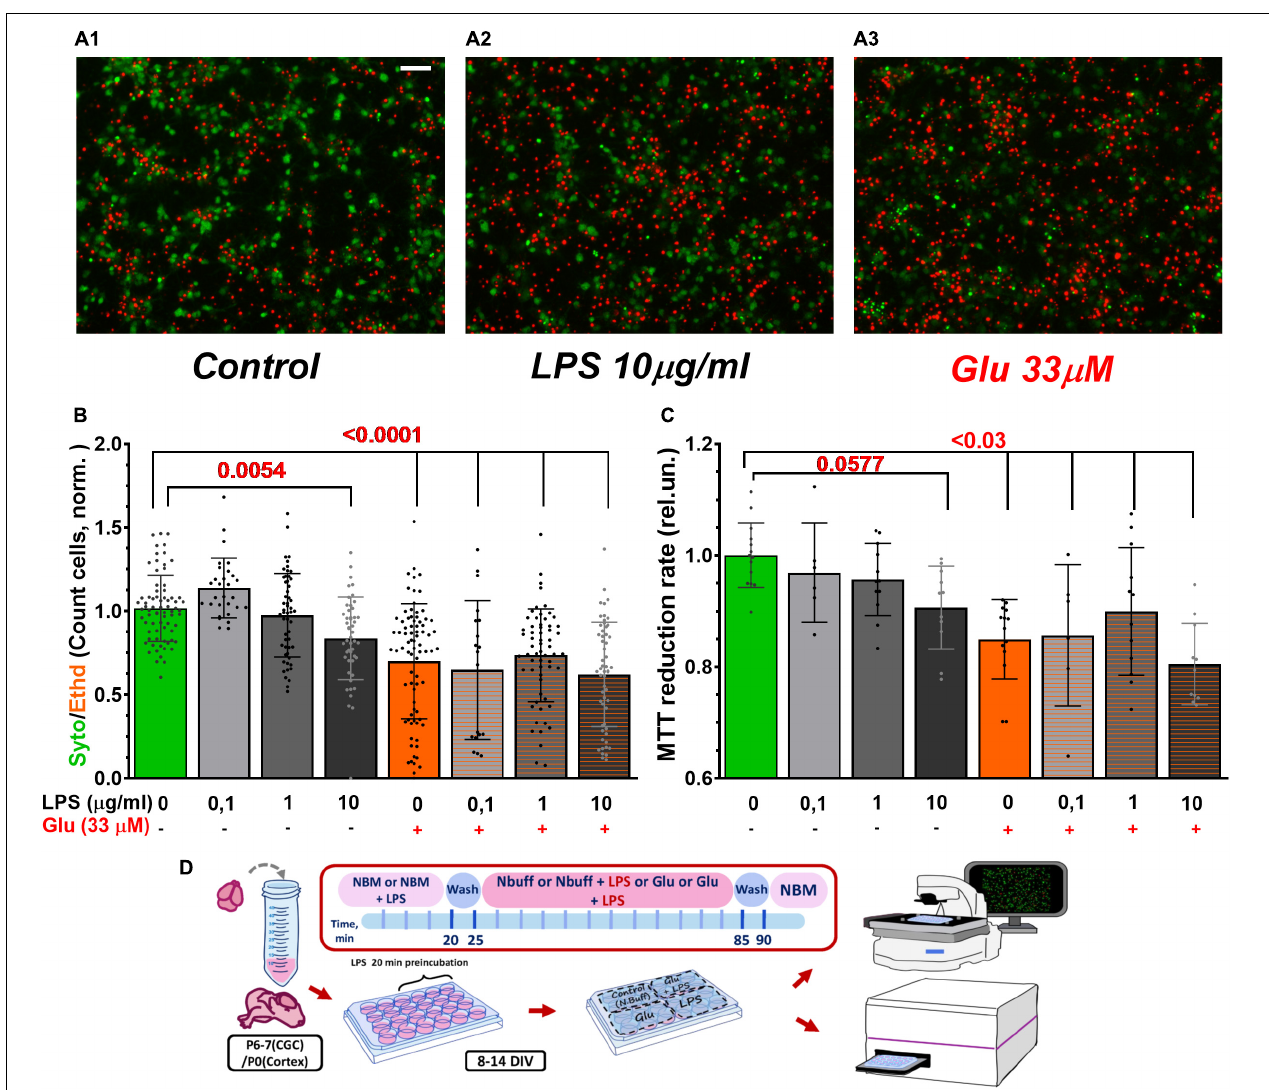
FIGURE 7 | LPS and Glu reduced the survival rate of cultured cerebral neurons evaluated by morphological (A,B) and biochemical (C) approaches. (A) Images of primary neuronal cultures from the rat cortex loaded with the vital fluorescent dyes. Color codes: Syto-13 - green cytoplasm and nucleus of live cells; EthD-1 - red fluorescence of dead cell nucleus. (A1) A typical image of a control culture, (A2) A culture exposed to LPS, and (A3) Culture treated with Glu. LPS and glutamate concentrations are indicated beneath the bars of the histogram. Exposure time of LPS, Glu, and their combined application was 30 min. (B) The ratio of the number of cells that had green Syto-13 fluorescence to the number of cells with red EthD-1 fluorescence normalized to the ratio (Syto/EthD) in control cultures. Each bar was obtained by counting 500–700 cells in 5 non-sister cultures (20–60 images for each group). (C) MTT assay of cell viability. The MTT to formazan reduction rate is the slope of the kinetic light absorption curve at 550 nm (A550) for the first 10 min since MTT addition; absorbance at 650 nm (A650) was considered background and subtracted from A550. The data are normalized relative to kinetics of light absorbance in the control wells. Scale bar in the A1 image corresponds to 50 µ m. 3 non-sister cultures (6–14 wells for each group). The data are presented as Means ± SD (One-way ANOVA + Sidak’s multiple comparisons test). Schematic of experimental design for panels A–C (D)